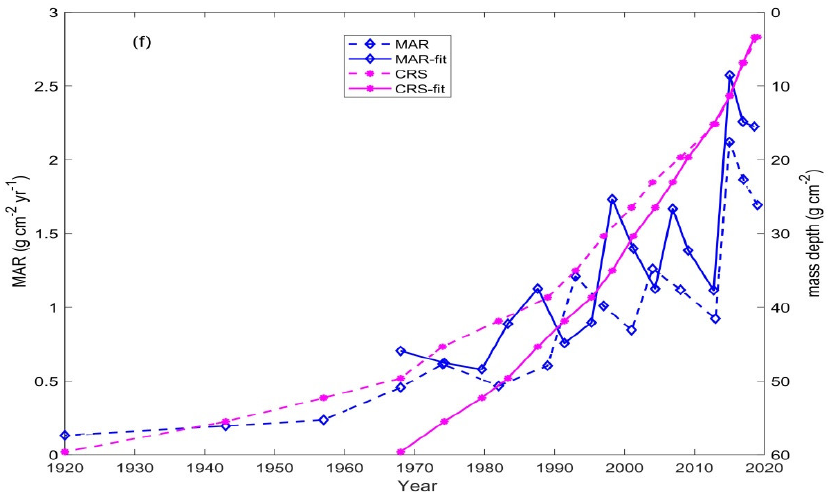
Figure 3. 210 Pb ex mass depth profiles for cores ( a ) AC1, ( b ) AC2 and ( c ) AC3, and their respective age–depth relationships in ( d – f ). Lines are defined in the legend.